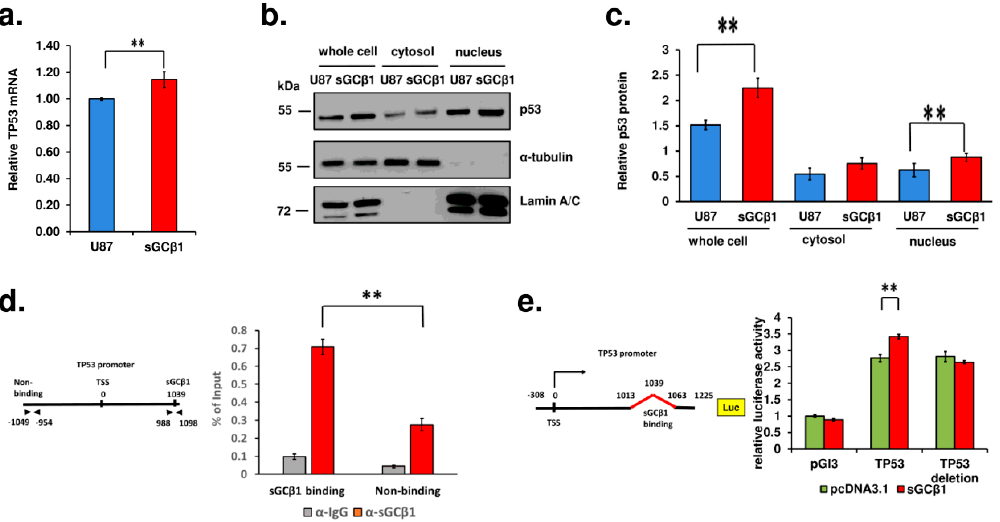
Figure 5. sGC β 1 interferes with p53 transcription. qRT-PCR (( a ); n = 6) and Western blot (( b , c ); n = 3) of p53 expression promoted by sGC β 1. A significant increase in the levels of p53 was detected after sGC β 1 overexpression (( b , c ); n = 3). An anti- β -actin antibody was used as a loading control for